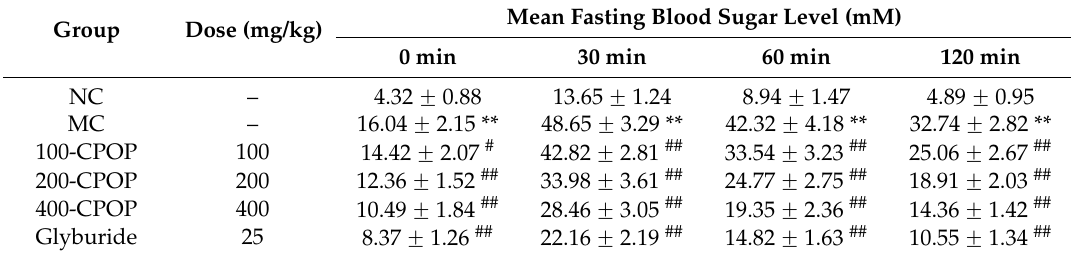
Table 2. Results of glucose tolerance test by study group ( x ˘ SD, N =